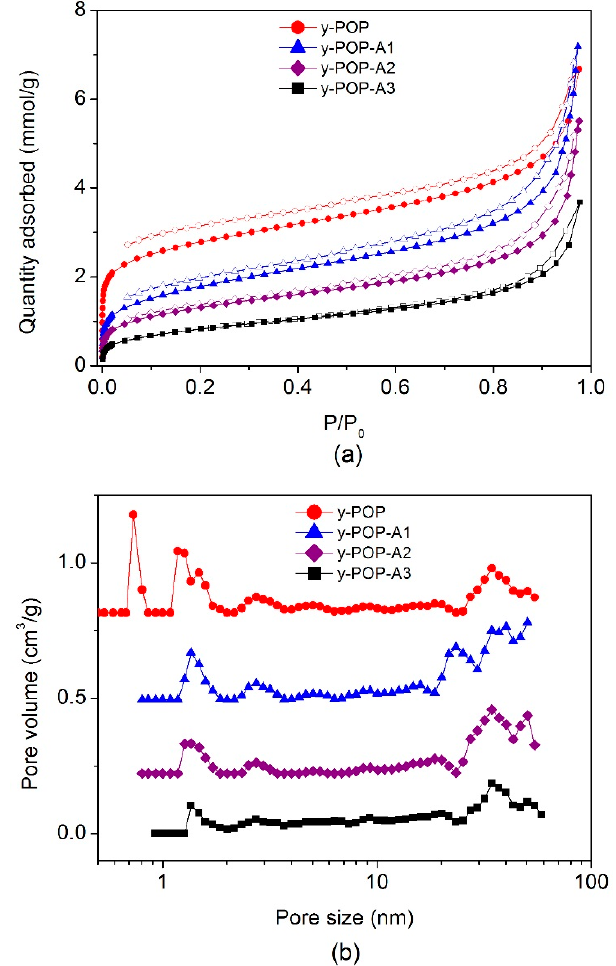
Figure 3. ( a ) N 2 adsorption / desorption isotherms of ynone-linked porous organic polymer (y-POP) and y-POP-NH 2 recorded at 77 K; ( b ) Pore size distribution analyses of y-POP and y-POP-NH 2 based on the adsorption branches using the density functional theory model.